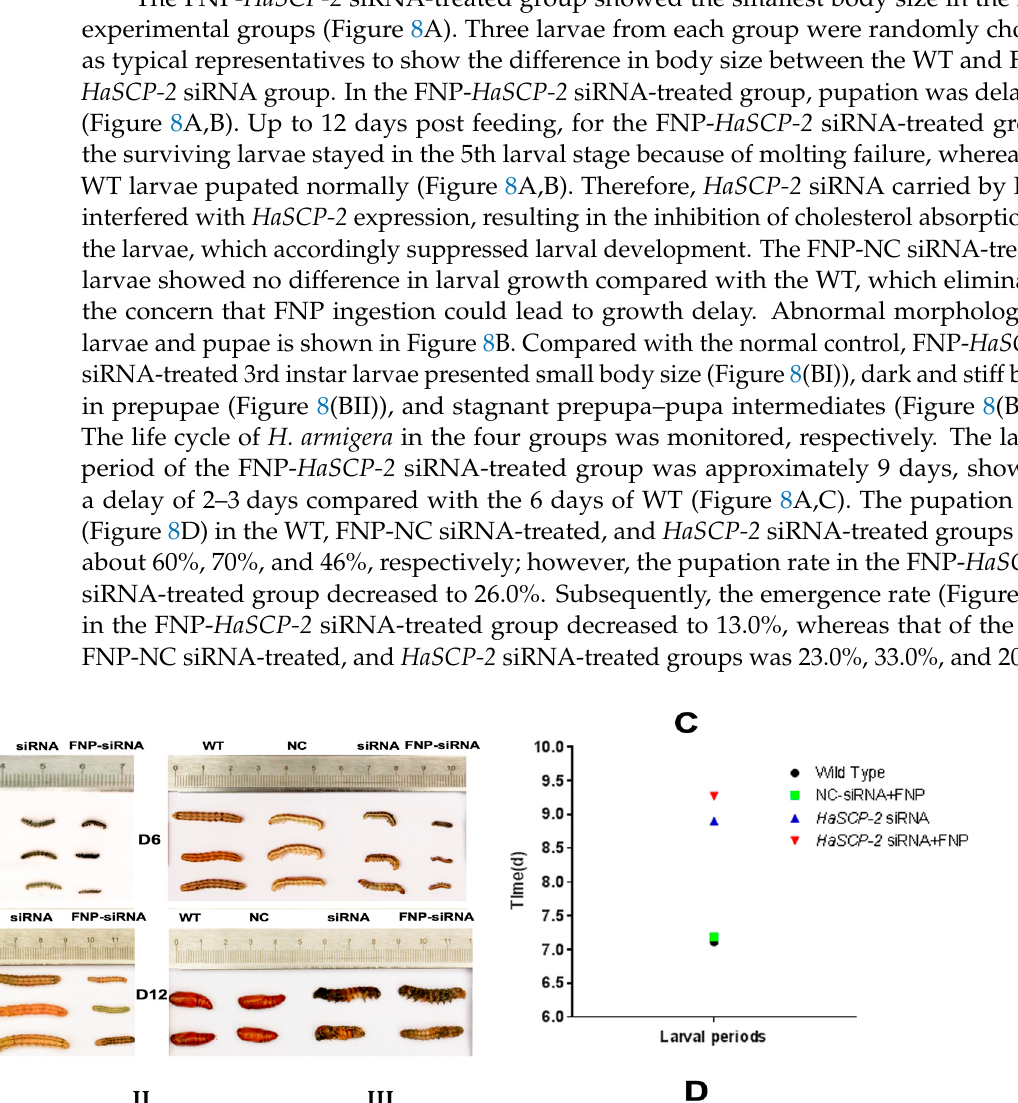
Figure 9. Life cycle analyses. ( A ) Analysis of average larval body length from day 2 to 8 post RNAi. ( B ) Analysis of average larval body weight from day 2 to 8 post RNAi. ( C ) Number of eggs. ( D )